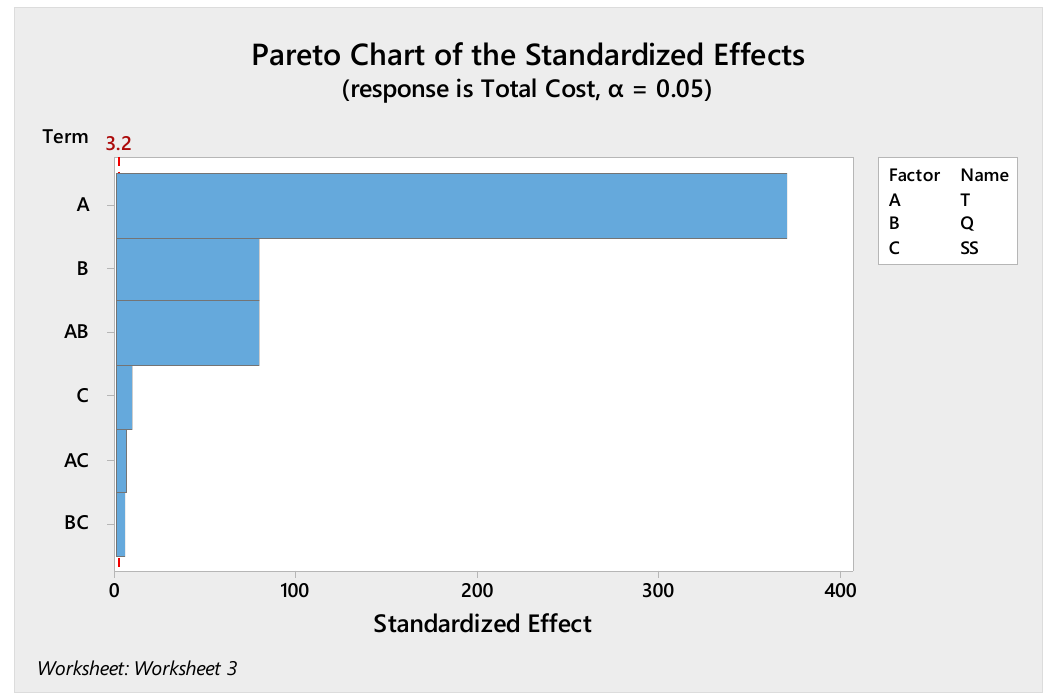
Figure 6. Pareto chart of the standardized effects.